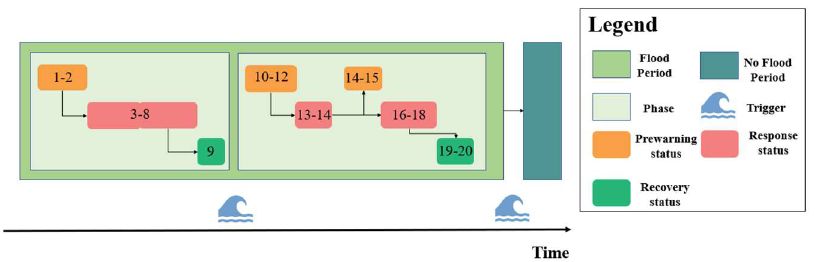
Figure 12. An example of multi-level dynamic expression under a certain object entity (the number in the circle represents the time element).